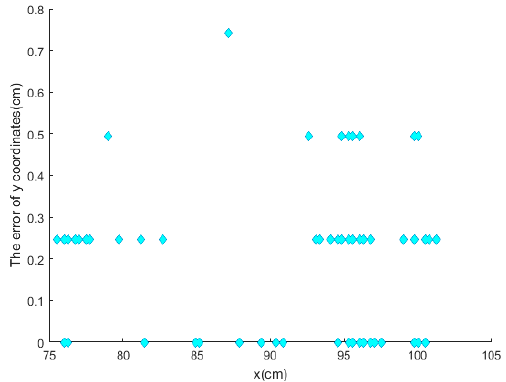
Figure 12. The error of position value of x coordinates.